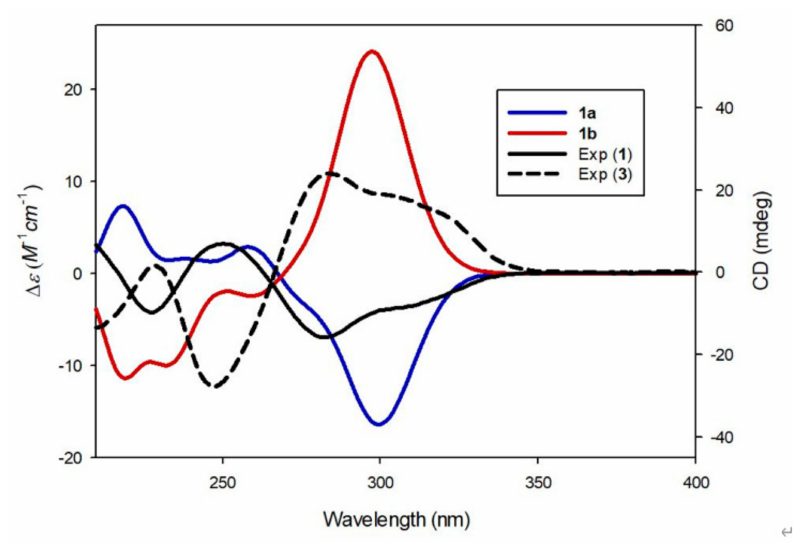
Figure 5. Experimental and calculated ECD spectra of compounds 1 and 3